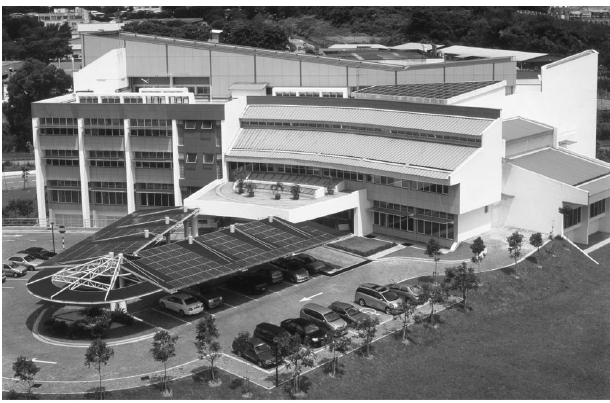
Figure 2. GEO Building, general view, from Malaysian Green Technology Corporation [50].